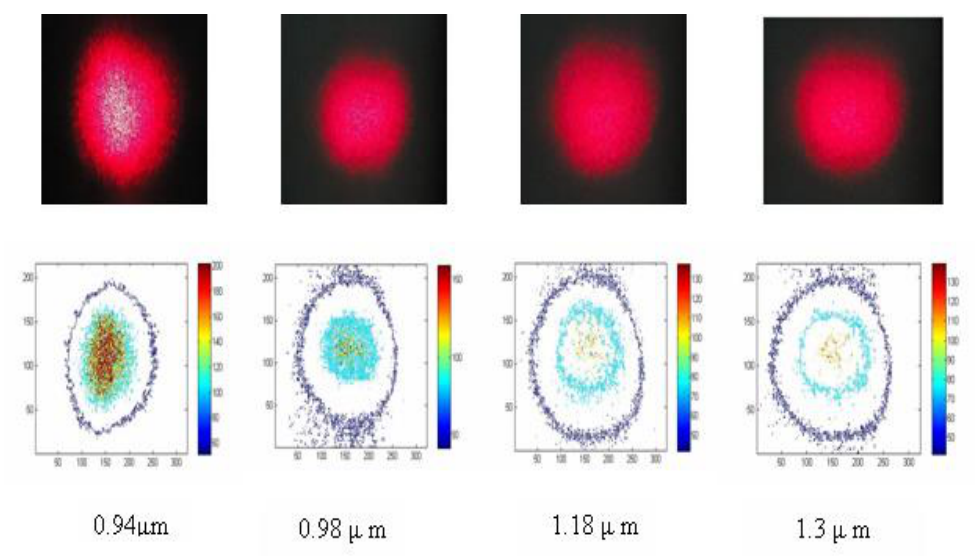
Fig.7: Four images of different spots with its